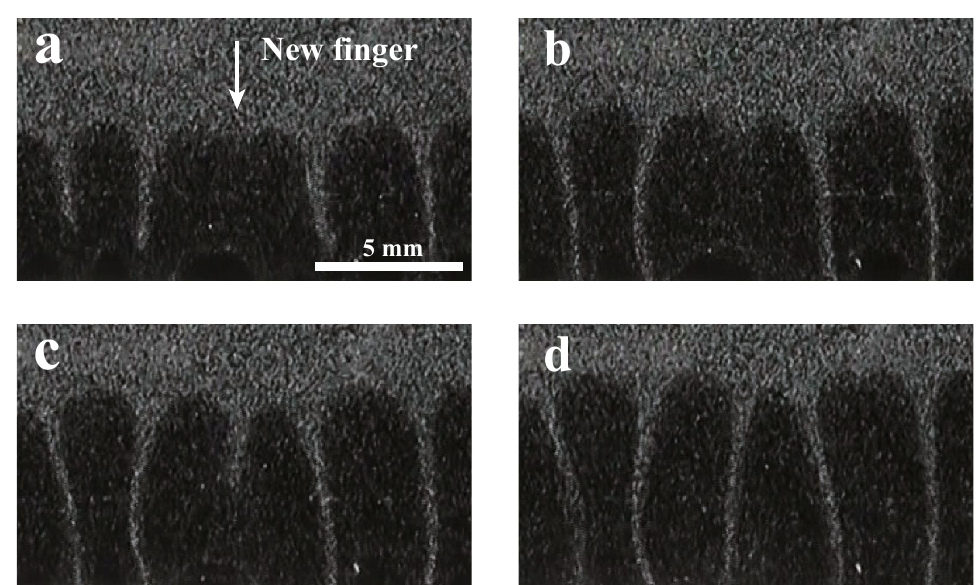
Figure 4. A new finger is intermittently formed during the intermediate stage of the growth of Rayleigh– Taylor-like instability in the gel system. t = ( a ) 440 s, ( b ) 460 s, ( c ) 480 s, and ( d ) 510 s. A new finger is often formed when the distance between existing fingers is large. The emergence of the new finger is also observed during the drop of the granular system. We use 6 wt% for the upper layer and 5 wt% for the bottom layer. T b = 26